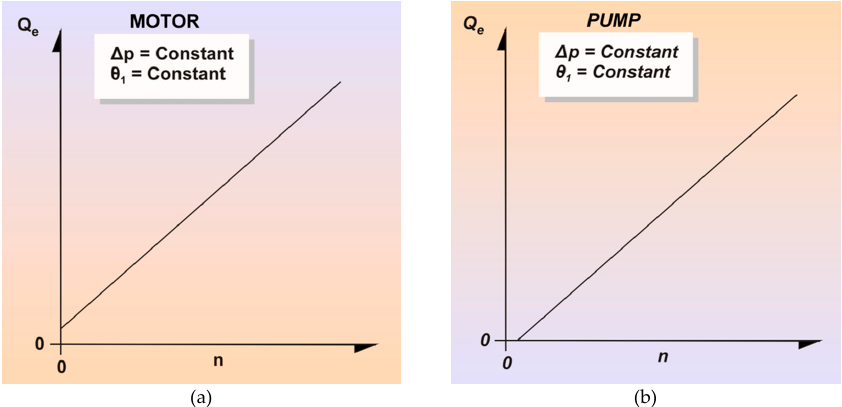
Figure 6. Volumetric flow vs. shaft speed for ( a ) a positive displacement motor and ( b ) a positive displacement pump.